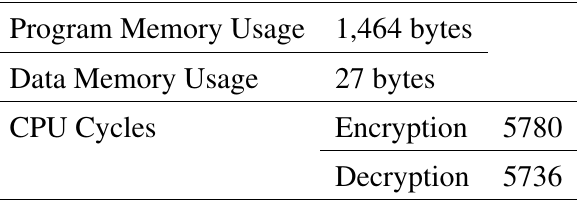
Table 9. Performance analysis of